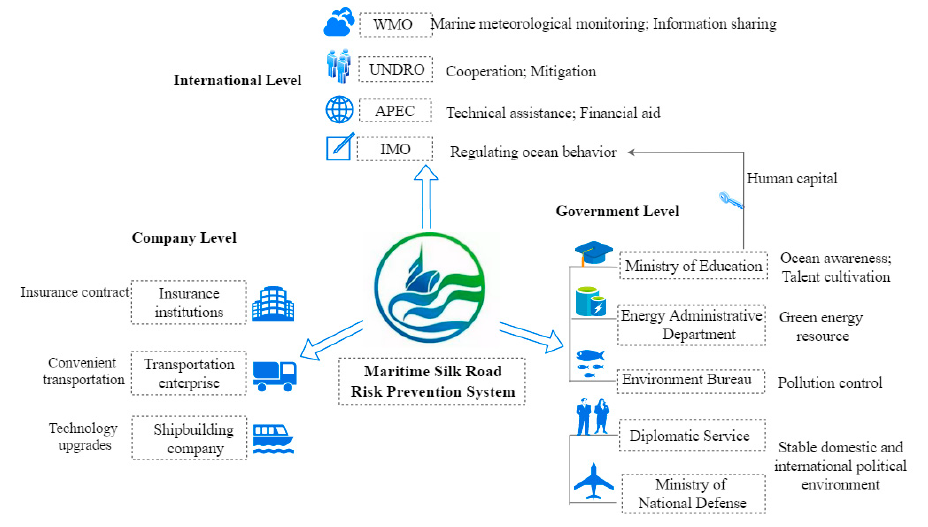
Figure 4. Application of the intelligent risk-prevention system of Marine Silk Road.